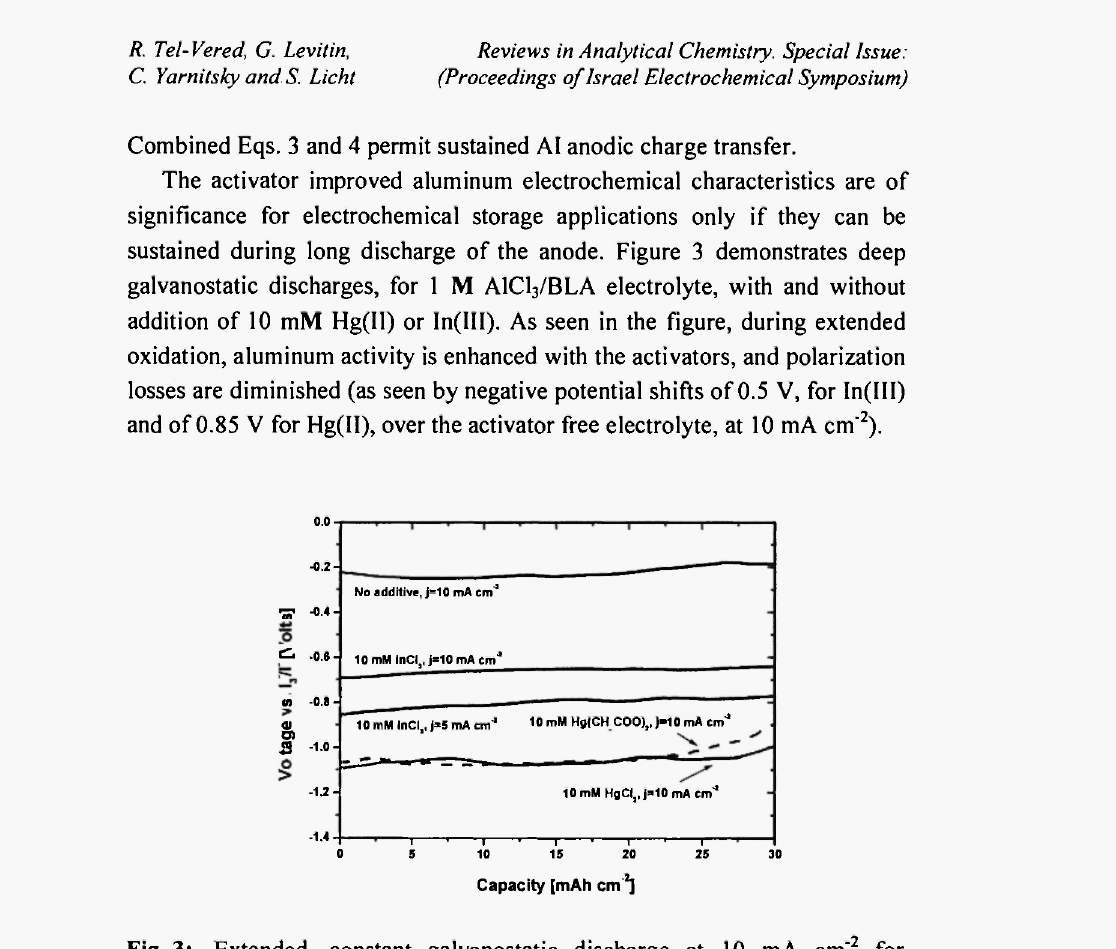
Fig. 3: Extended, constant galvanostatic discharge at 10 mA cm" 2 for 99.995% Al anode in 1 Μ A1C1 3 /BLA electrolyte, as indicated with and without 10 mM In(III) and